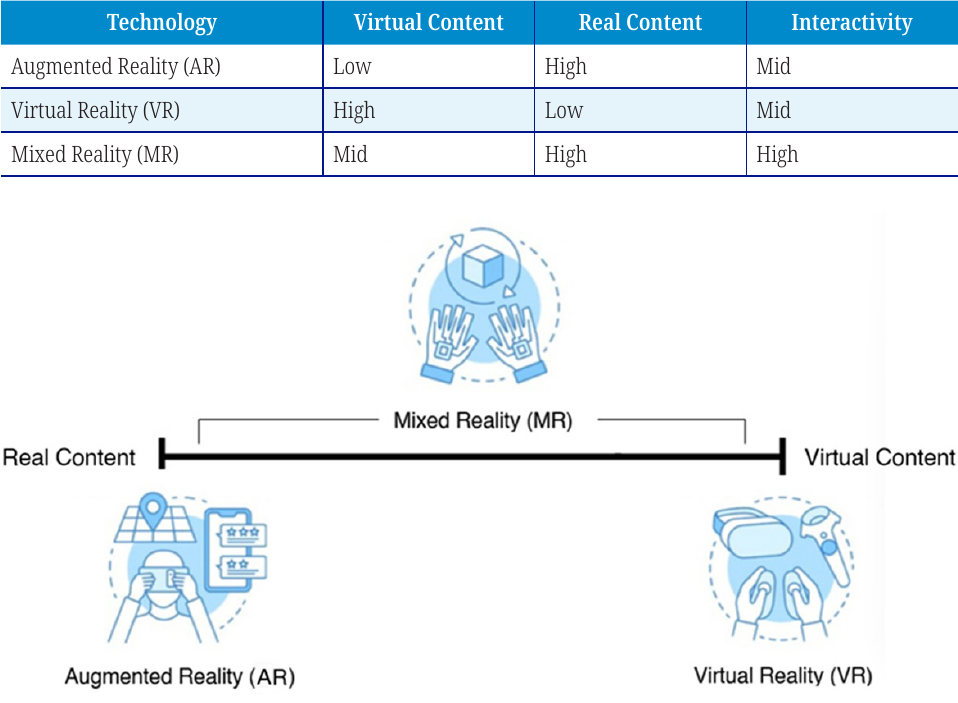
Table 8. Comparison of AR, VR, and MR